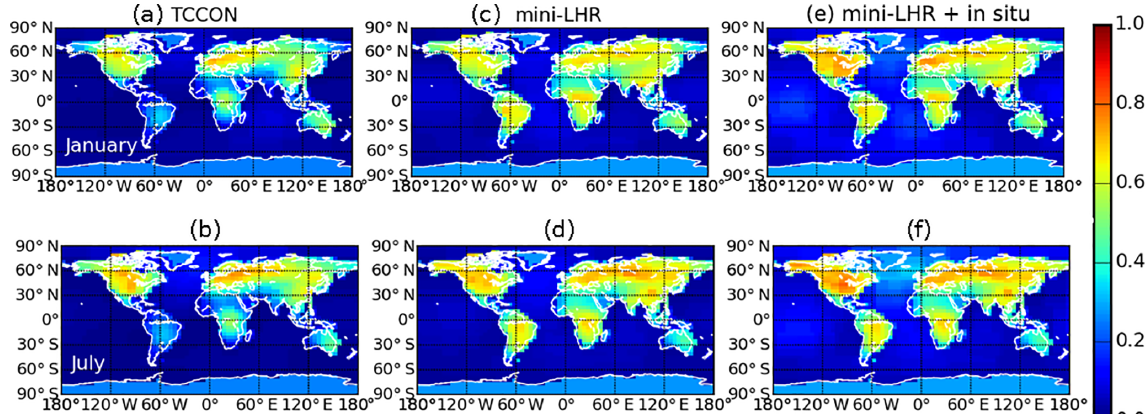
Figure 10. Theoretical improvement in the knowledge of CO 2 fluxes for a nominal (a, c, e) January and (b, d, f) July as determined by the γ factor, defined in the main text, for the (a, b) mini-LHR, (c, d) TCCON, and (e, f) combined mini-LHR–NOAA in situ flask measurement